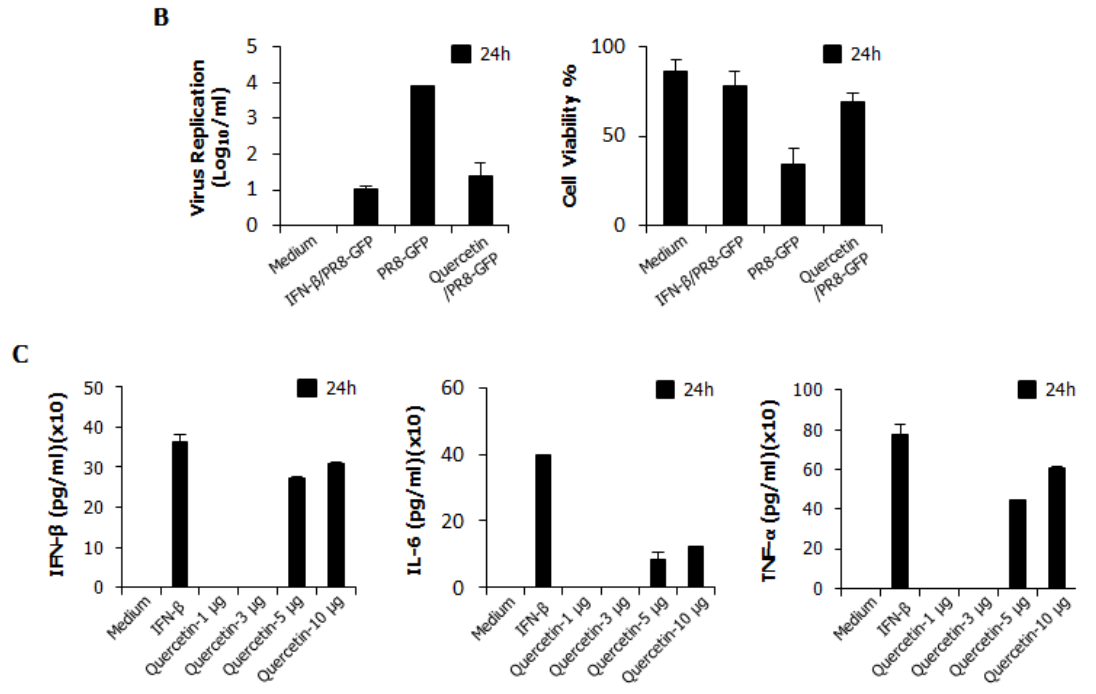
Figure 6. Anti-influenza (PR8-GFP) effect of Quercetin and induction of IFN-β and pro-inflammatory cytokines in RAW264.7 cells. ( A ) RAW264.7 cells treated with media alone, 5.0 µg/mL Quercetin, or 1000 unit/mL recombinant mouse IFN-β, 12 h prior to infection with PR8-GFP at an MOI of 1.0 The GFP expression images were obtained at 24 hpi (200× magnification); ( B ). Viruses were titrated from the infected cells for PR8-GFP.